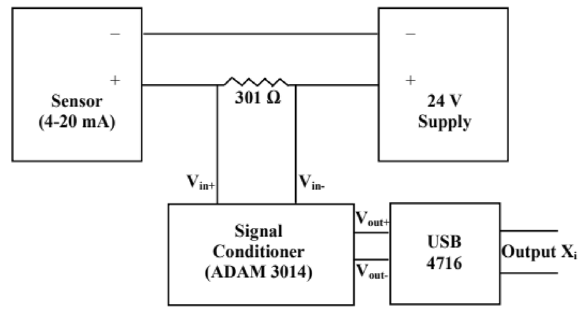
Figure 4. Sensor connection with signal conditioner.